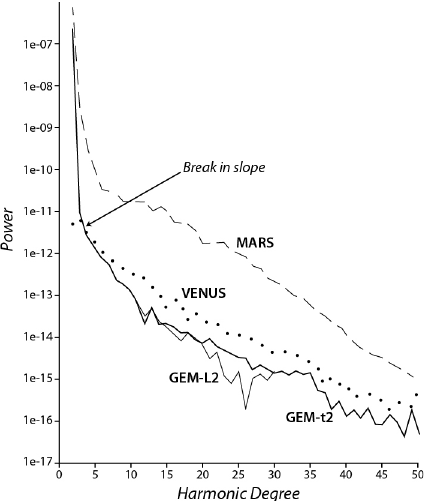
Figure 1. Power spectra for Earth, Venus, and Mars from sets of spherical harmonic coefficients. Earth (solid line) is from GEM-L2 (Lerch et al., 1982) and GEM-t2 (Marsh et al., 1990), Venus (dotted line) is from Nerem et al. (1993), and Mars (dashed line) is from Smith et al. (1993). If the horizontal harmonic degree axis were plotted as a log scale, then the spectra would be nearly a straight line.